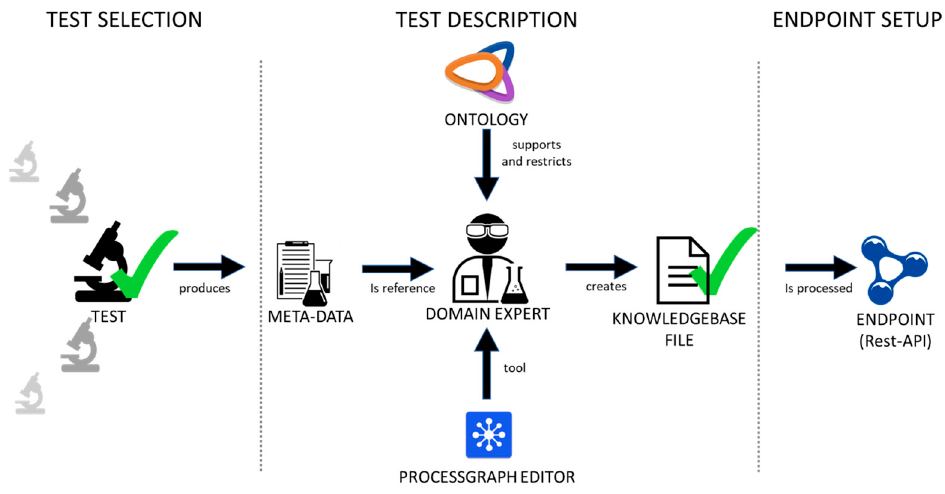
Figure 6. Digital workflow. The domain expert (DE) is at the center of the process. The ontology plays a purely functional role in the digital workflow. The main objective is to transform experimental data into triples (see Figure 7) irrespective of the source format. These triples are semantically connected according to the ontology, which fulfills a “scaffolding” role. This means that the ontology, once used to build the knowledgebase file, remains unaffected by the digital workflow . The value of a bottom-up development and collaboration approach to OEngMs has been demonstrated. Both the development and the collaboration here remain horizontal . Semantic reflections and tasks are used to transform the data into triples, but not to update the ontology. The importance of a feedback loop between the ontology engineer (OE) and the DE to adjust this digital workflow and the selected ontology has been recognized, but not yet implemented. The feedback loop includes activities such as ontology updating (minor changes) , ontology restructuring (analyzing the initial knowledge model and correcting the ontology according to the result of this analysis) , ontology pruning (discarding entities that are no longer relevant) or ontology customization (adapting the ontology to some user needs)